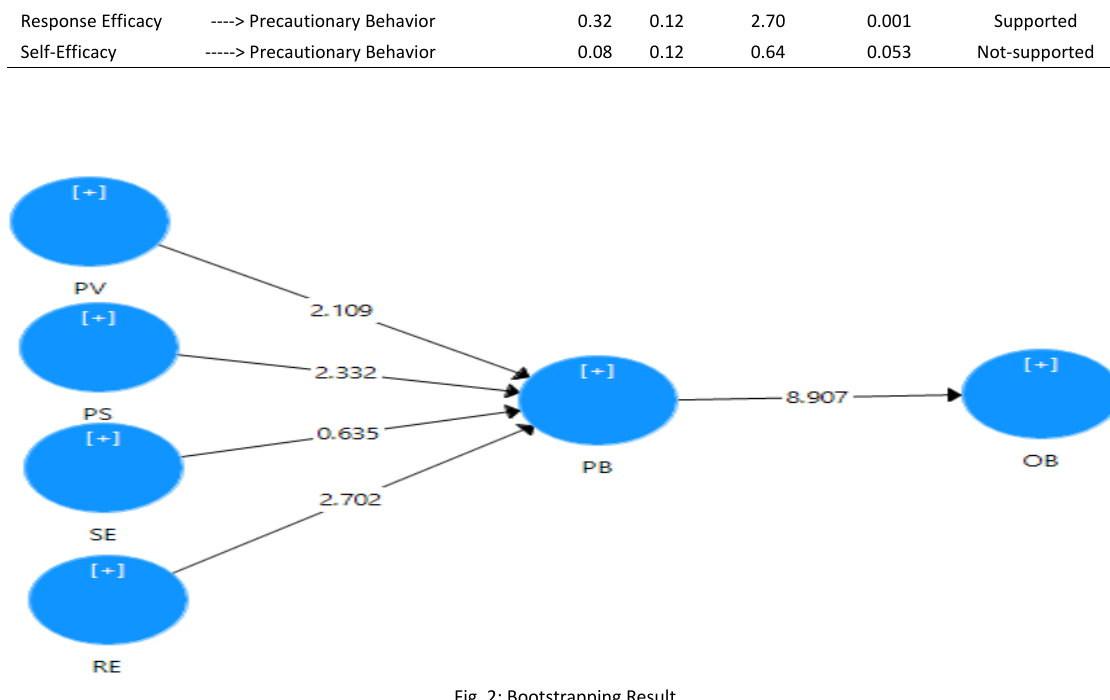
Fig. 2: Bootstrapping Result